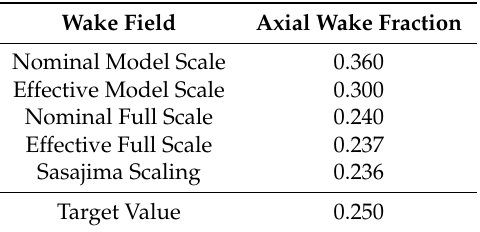
Table 1. Wake fractions before